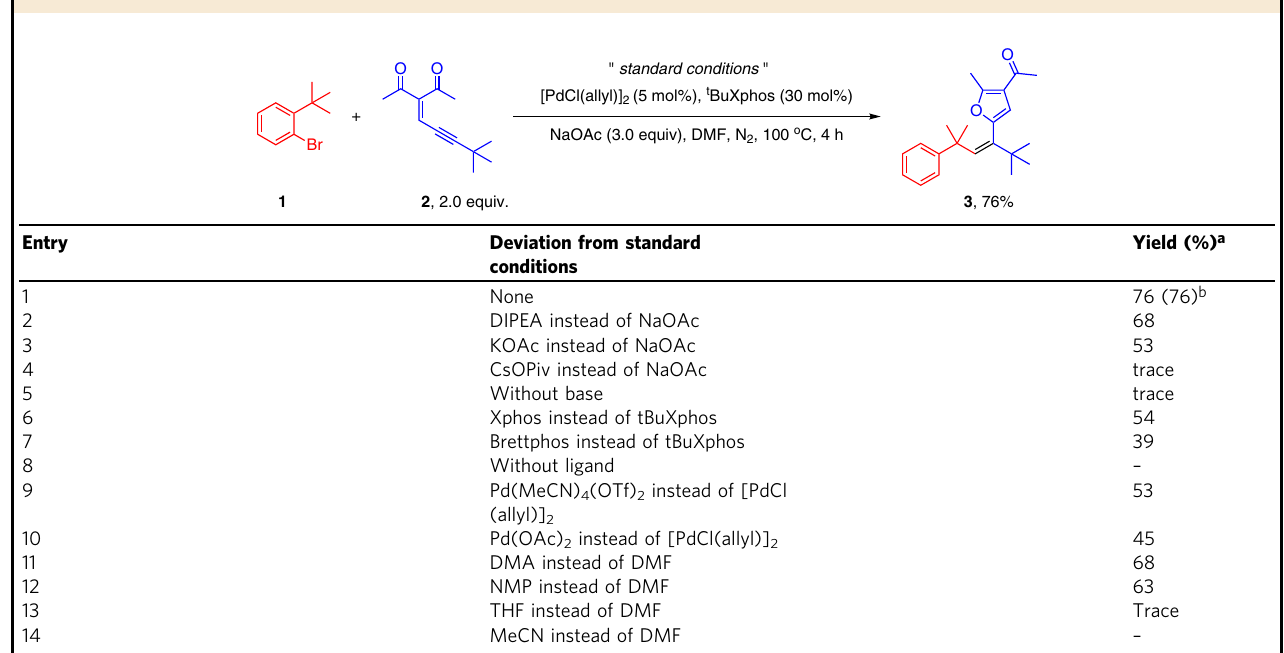
Table 1 Catalyst screening and optimization of the reaction